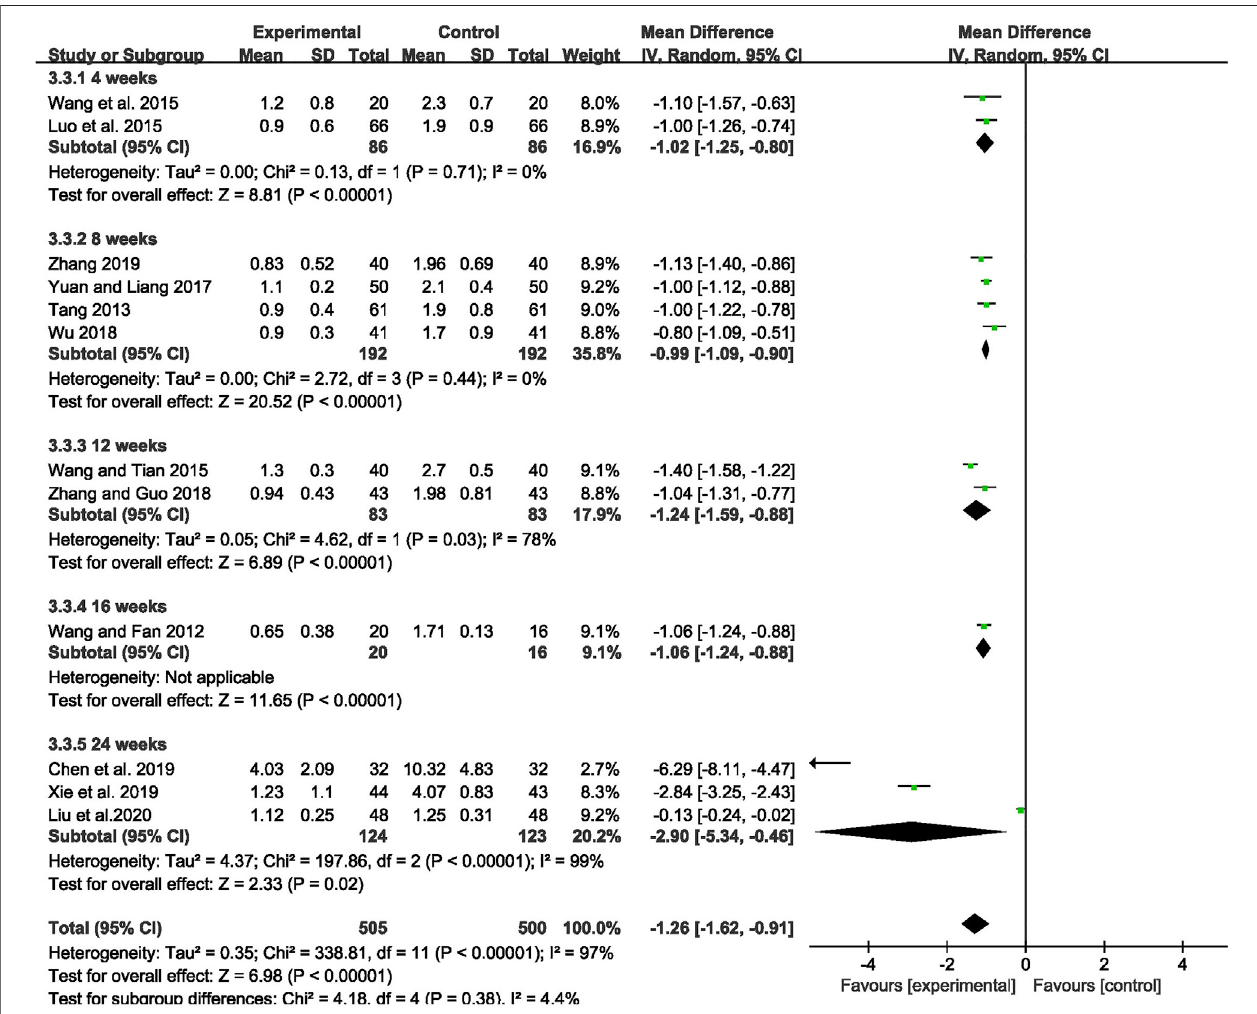
FIGURE 4 | Forest plot displaying the results of subgroup analysis of CHM+AEDs vs. AEDs for monthly seizure frequency in patients with IE according to various treatment duration.